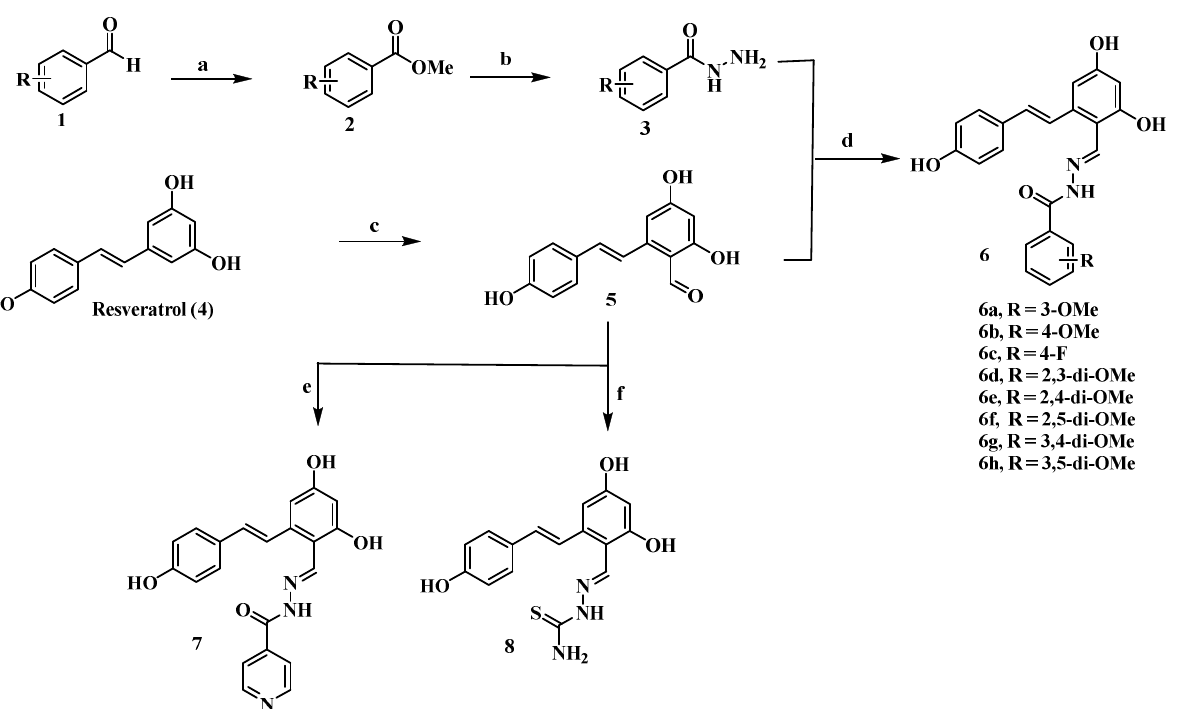
Scheme 1. Synthesis of resveratrol-hydrazone hybrids. Reagents and conditions: ( a ) I 2 ,